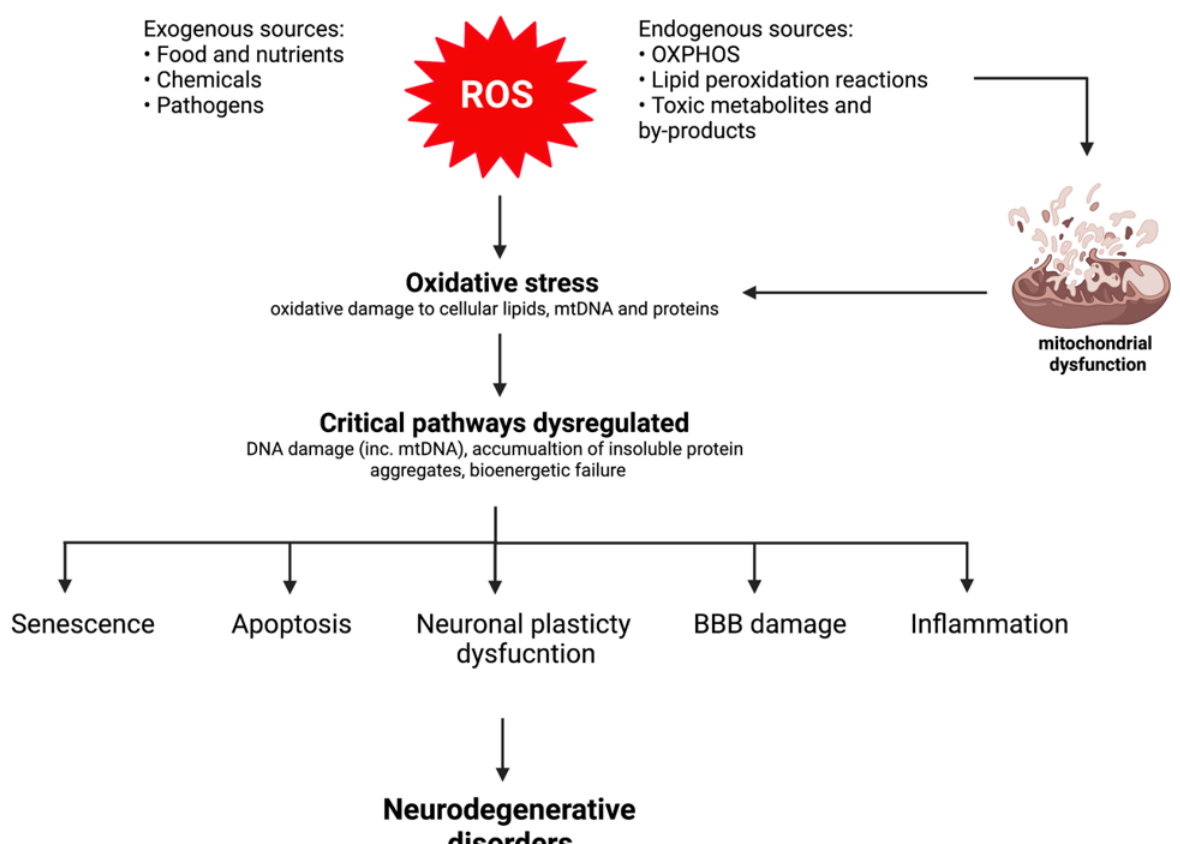
Figure 3. Mitochondrial dysfunction and oxidative stress are key events triggering neurodegeneration. Mitochondria are vulnerable targets for oxidative stress. ROS accumulation from mitochondria and endogenous and exogenous sources can cause oxidative damage to cellular components as they go unchallenged from diminished antioxidant defence systems. A chronic oxidation environment causes dysregulation of the critical pathways causing a lower gene expression of the antioxidant enzymes and transcription factors involved in mitochondria-dependent apoptosis. A combination of these factors results in neuronal apoptosis and senescence, triggering neurodegeneration (created using biorender.com). ROS — reactive oxygen species; OXPHOS — oxidative phosphorylation; mtDNA — mitochondrial DNA; BBB —blood−brain barrier.